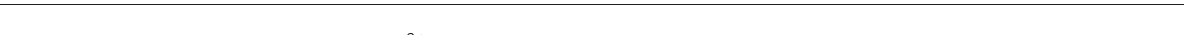
Fig. 1 Hair-cell mechanosensation and presynaptic Ca 2 + activities. a Cartoon neuromast organ illustrating hair cells (cyan) with apical mechanosensory bundles, basal presynaptic ribbons (magenta), supporting cells (gray), and the associated afferent processes (blue). Bundles made up of stereocilia (cyan) and kinocilia (gray) are oriented to respond to either anterior or posterior stimuli. b , c Images of a double transgenic neuromast expressing GCaMP6s- CAAX (labels apical and basal hair-cell membranes) and Ribeye b-mCherry (labels presynaptic ribbons) in hair cells. A top-down cross-section reveals mechanosensory bundles ( b ), or the synaptic plane ( c ). d , f Functional Ca 2 + imaging acquired from the neuromast in b , c during a 2-s 5 Hz (anterior – posterior directed square wave) mechanical stimulus that stimulates all hair cells. Spatial patterns of GCaMP6s Ca 2 + signals during stimulation (right panels) are colorized according to the Δ F / F heat maps and superimposed onto a baseline GCaMP6s images (left panels). At the apex, robust mechanosensitive Ca 2 + signals are detected in nearly all bundles ( d ), while only a subset of hair cells shows robust presynaptic Ca 2 + signals at their base ( f ). e , g Temporal curves of mechanosensitive (1.5 μ m ROIs) or presynaptic (3 μ m ROIs) Ca 2 + responses of all 16 hair cells in this example, highlighting four cells with robust presynaptic Ca 2 + signals (cells 1, 3, 4, 5, labeled in d , f ). h Enlarged image of the dashed box in c and f highlights an active (cell 1) and a silent (cell 2) cell. i Using 1.5 μ m ROIs ( h ), in cell 1, the Ca 2 + signals are larger on ribbons compared to off ribbon (blue traces) while in cell 2, Ca 2 + signals off and on the ribbon are similar (red traces). j In response to an unsaturated stimulus, there is a slight correlation between presynaptic and mechanosensitive Ca 2 + signals, R 2 = 0.26, n = 94 cells. k Using a threshold of Δ F / F = 20%, the active and silent cells in j were separated. Mechanosensitive responses were on average larger in active cells (115.1% ± 11.79, n = 35) versus inactive cells (54.71 ± 4.44, n = 59). A Wilcoxon test was used in k ; *** p < 0.0001. Scale bars = 5 μ